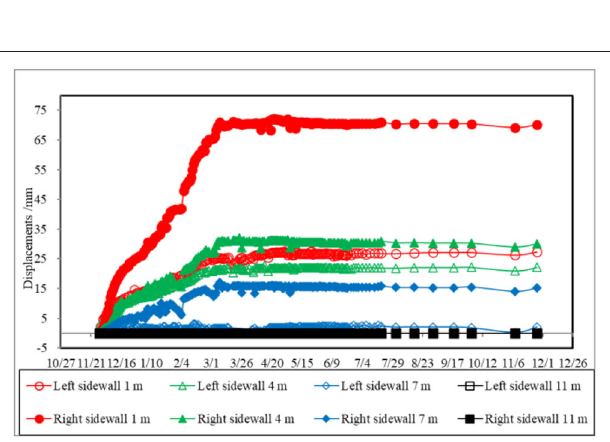
FIGURE 11 | Displacements curves of the monitoring section D3K342 +